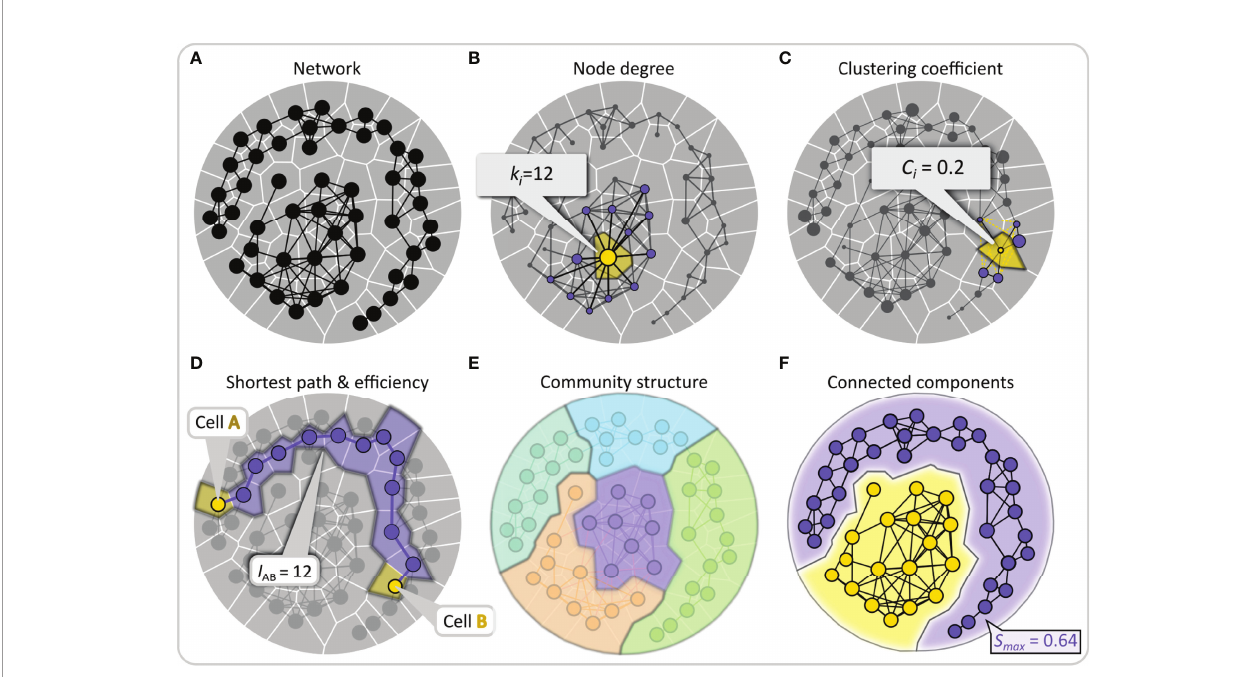
FIGURE 3 | Quantifying intercellular connectivity patterns with conventional network metrics. (A) Schematic representation of a multicellular system as a network composed of nodes (cells) and edges (connections or functional associations between cells). (B) Nodes are scaled based on the number of the neighbors to which they are directly connected, i.e., their degree. This feature is shown schematically for the yellow node, with the direct neighbors colored purple. (C) The clustering coef fi cient describes the tendency of nodes to cluster together and is de fi ned as the number of existing connections between the neighbors of that node divided by the number of all possible connections between them. This property is illustrated by the example of the yellow-colored node, to which non-existing yellow edges between the purple neighboring nodes have been added. (D) The shortest path length between any two nodes is the number of edges that form the shortest path between them. Lower average shortest paths of a network indicate more ef fi cient communication abilities. This feature is highlighted by two yellow nodes representing the source and destination nodes and the purple-colored nodes forming the shortest path. (E) A community consists of a group of nodes that have a higher connection density compared to the whole network. A well-pronounced community structure implies an internal network organization into functional modules. In panel (E) , nodes are color-coded according to their membership in a community. (F) A group of nodes that are directly or indirectly connected to each other forms a connected component and stands for reachability within the network. The relative largest connected component representing the fraction of nodes that are connected either directly or indirectly is denoted by S max